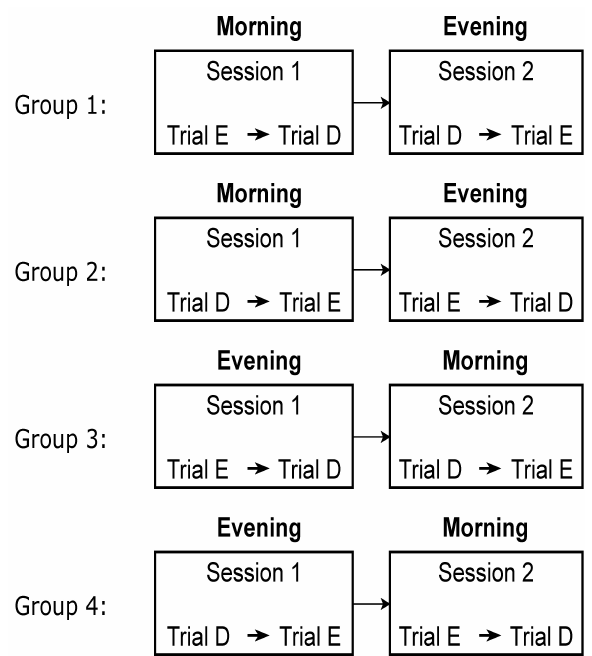
Figure 2. A schematic of the Latin Square experiment design. Trial E indicates an easy task and trial D indicates a difficult task. The order of the easy and difficult was balanced between the sessions, for each participant.